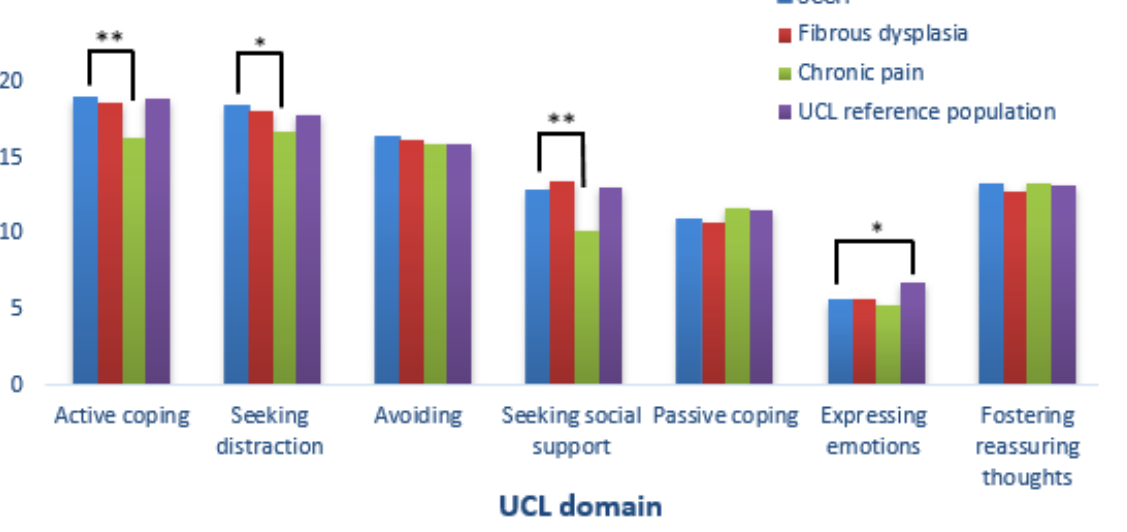
Figure 4. Bar chart comparing the UCL (Utrecht Coping List) scores between CNO/SCCH patients and the UCL reference population, Fibrous Dysplasia, and patients with chronic pain. Significance was illustrated by * p < 0.01 or ** p < 0.001.